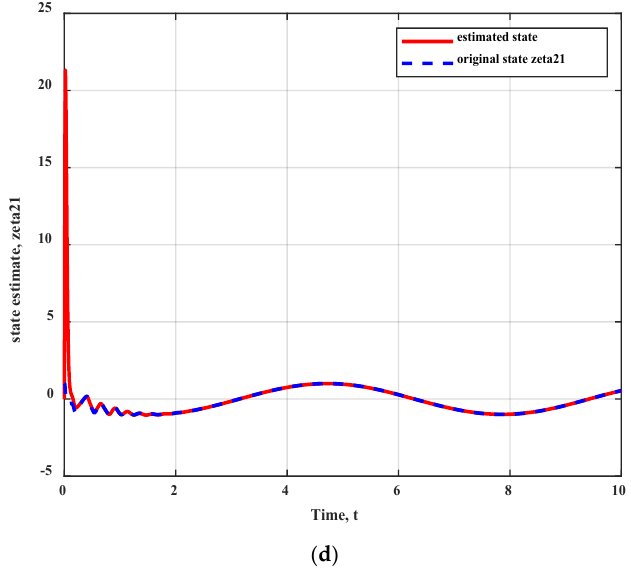
Figure 4. The estimated states response of the hypothetical MIMO system controlled by ADRC based on LESO and SMHOESO ( a ) state estimate ˆ ξ 1,2 using LESO, ( b ) state estimate ˆ ξ 2,1 using LESO, ( c ) state estimate ˆ ξ 1,2 using SMHOESO, and ( d ) state estimate ˆ ξ 2,1 using SMHOESO. Table 2. The numerical results of case study